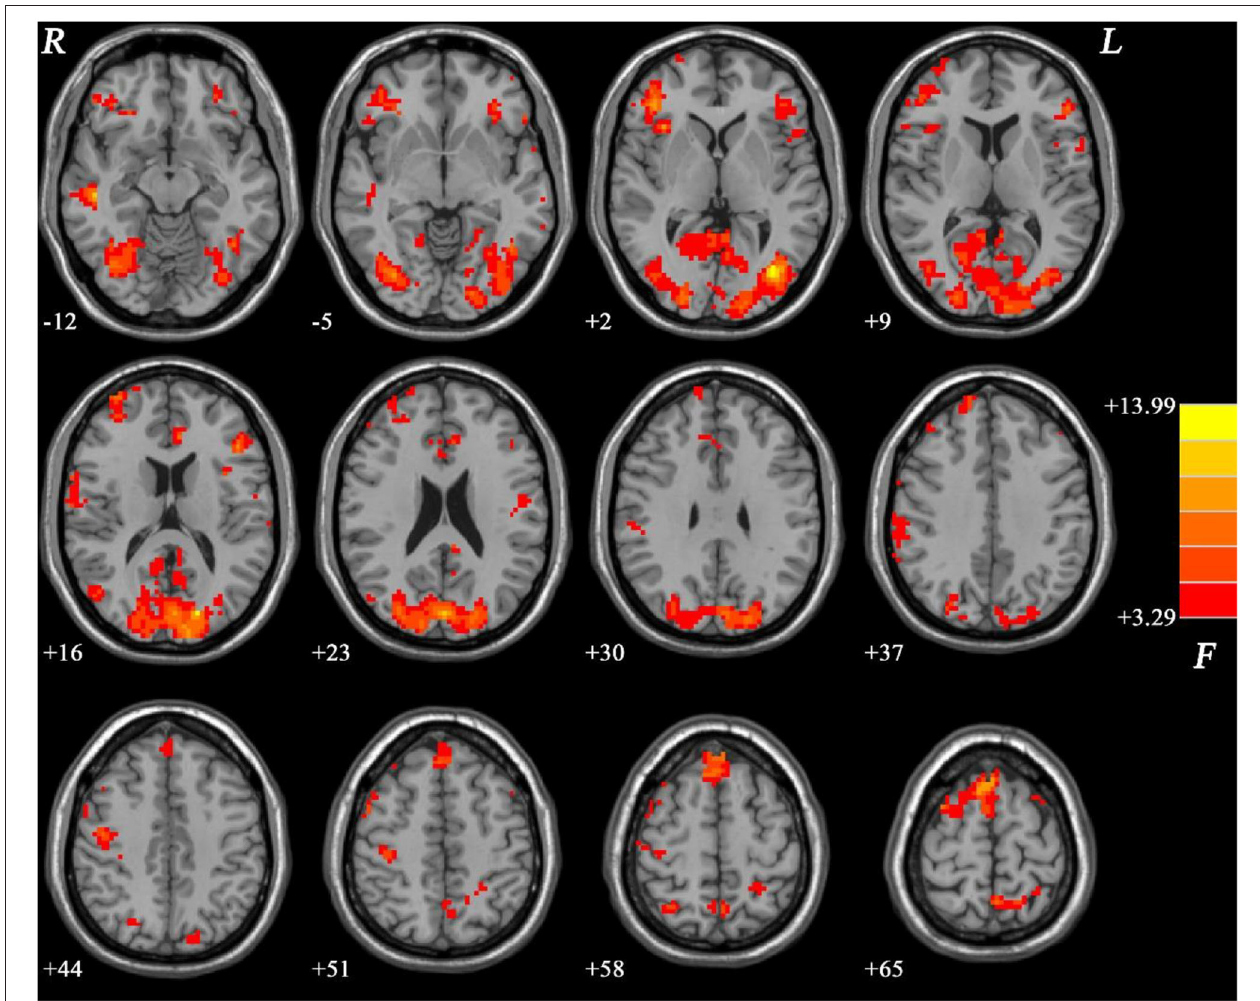
FIGURE 1 | ANCOVA results (age, years of education, and framewise displacement as covariates) showing group differences of fALFF values across three groups in brain regions. Color bar indicates F -values of ANCOVA. fALFF, fractional amplitude of low-frequency fluctuations; ANCOVA, analysis of covariance.